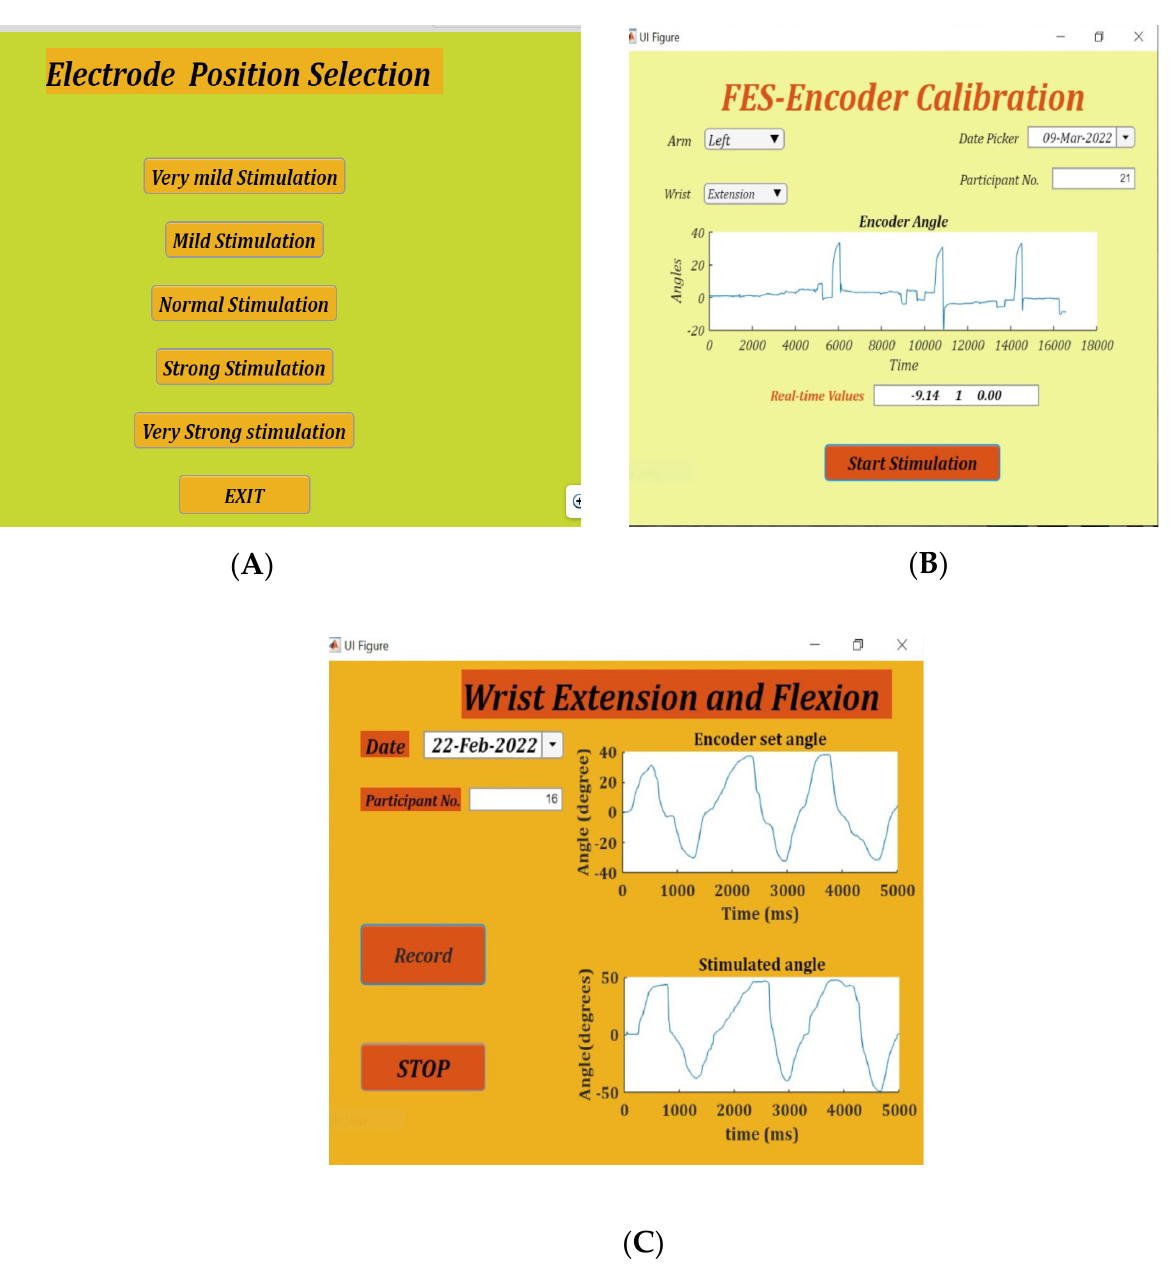
Figure 2. The three apps, namely. ( A ): Position Selection—used to determine the correct position of flexion/extension electrodes. ( B ): FES-Encoder Calibration—for obtaining the flexion/extension calibration tables, and ( C ): Set-stimulate Record angles app—for final recording of wrist set and stimulate angles with real-time feedback.